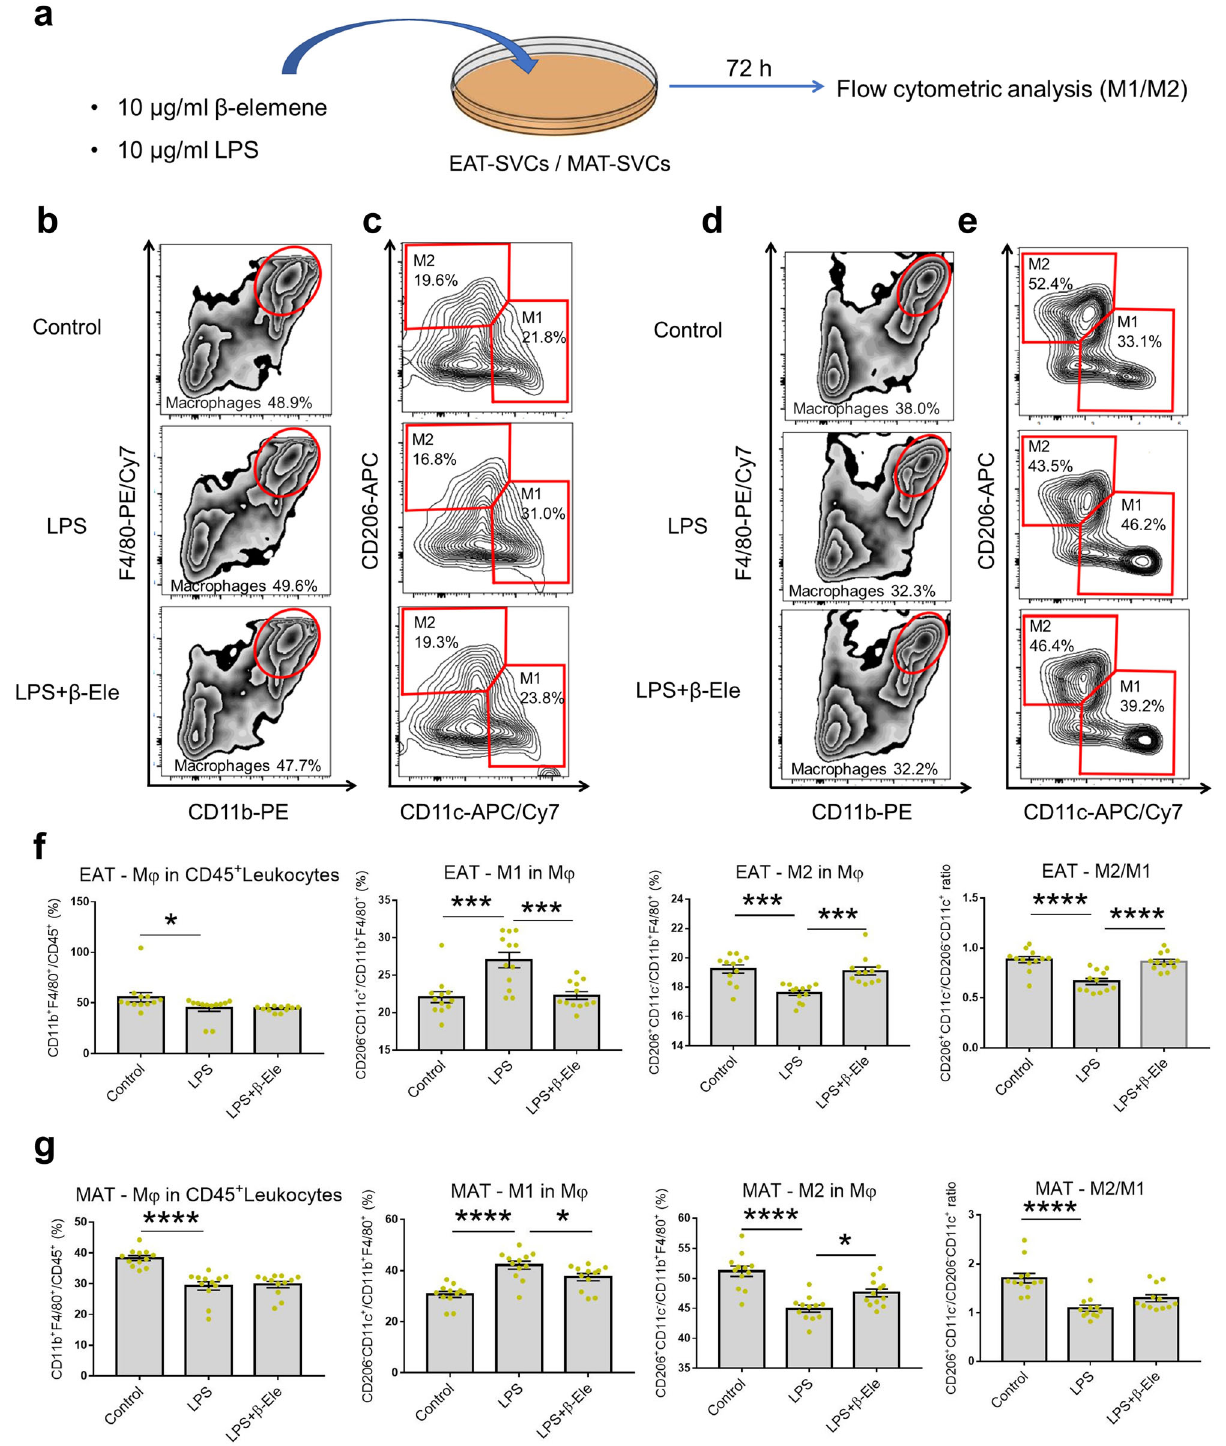
Fig. 4 Effects of β -elemene on regulating ATMs in white adipose tissue under LPS stimulation in vitro. a Cell culture system of EAT/MAT-SVCs under LPS stimulation in vitro for fl ow cytometric analysis. b – e SVCs of EAT or MAT were cultured with LPS (10 μ g/ml) and β -elemene (10 μ g/ml). After culture for 72 h, fl ow cytometry was used to identify F4/80 + CD11b + M φ s in CD45 + leukocytes, CD206 − CD11c + M1 M φ s and CD206 + CD11c − M2 M φ s in total M φ s. Total M φ s ( b ), M1 and M2 M φ s ( c ) in CD45 + leukocytes of EAT-SVCs. Total M φ s ( d ), M1 and M2 M φ s ( e ) in CD45 + leukocytes of MAT-SVCs. f , g Ratio of M φ s in CD45 + leukocytes, M1 M φ s in total M φ s, and M2 M φ s to M1 M φ s of EAT-SVCs ( f n = 12) and MAT-SVCs ( g n = 12). Data represent individual wells. Control: normal control, LPS: SVCs with LPS (10 μ g/ml) stimulation, LPS + β -Ele: SVCs with LPS (10 μ g/ml) stimulation under treatment with β -elemene (10 μ g/ml). The results are shown as the mean ± SEM. * p < 0.05, *** p < 0.001, **** p < 0.0001 versus the LPS group assessed using one-way ANOVA followed by Dunnett ’ s multiple comparisons. The results were from three independent experiments with similar results.